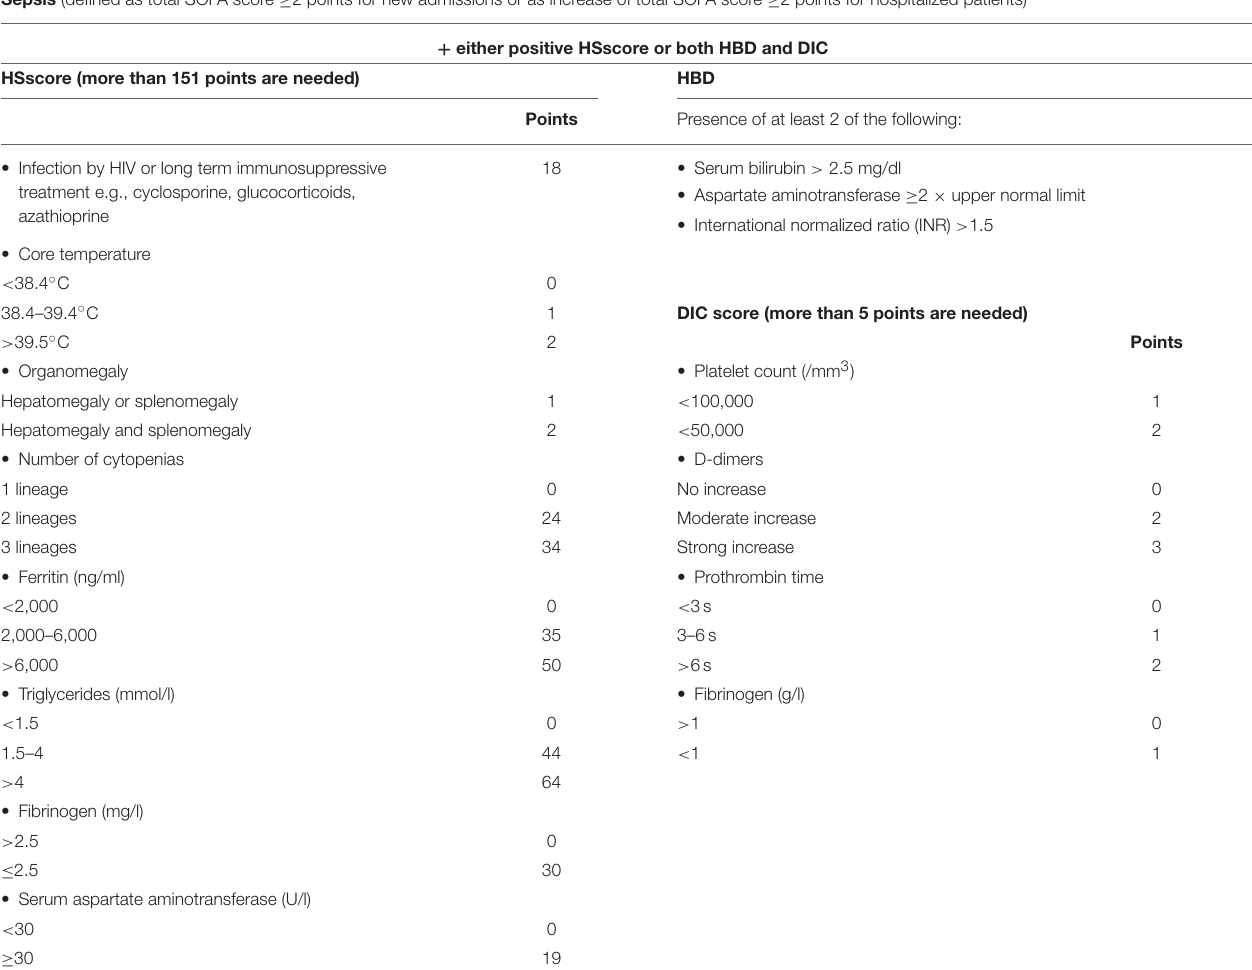
TABLE 2 | Suggested classification criteria for macrophage activation-like syndrome in sepsis used in the manuscript by Kyriazopoulou et al. Sepsis (defined as total SOFA score ≥ 2 points for new admissions or as increase of total SOFA score ≥ 2 points for hospitalized